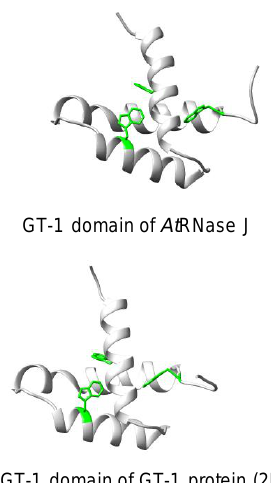
Figure 2. Comparative GT-1 domain structures. Top, three-helix model of amino acids (815–874) of the Arabidopsis RNase J ( At RNase J) GT-1 domain, based on (bottom) PDB 2EBI (GT-1 transcription factor amino acids 81–152), built using the NMR-solved structure as a template [62]. The three conserved tryptophan residues are in green. (Acquired with copyright permission from [52]).